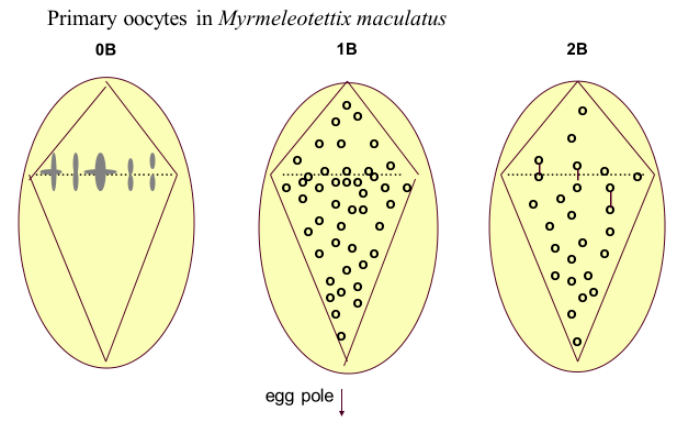
Figure 4 . Meiotic drive in primary oocytes of Myrmeleotettix maculatus , based on Hewitt [48]. The 0B nucleus shows the seven A chromosome bivalents lined up at the equator of the asymmetrical spindle at metaphase I. In the 1B and 2B nuclei there are more Bs in the region of the nucleus which will form the egg cells. 2B bivalents are shown as joined dots. This preferential chromosome distribution matches very closely the level of preferential transmission determined from breeding experiments.